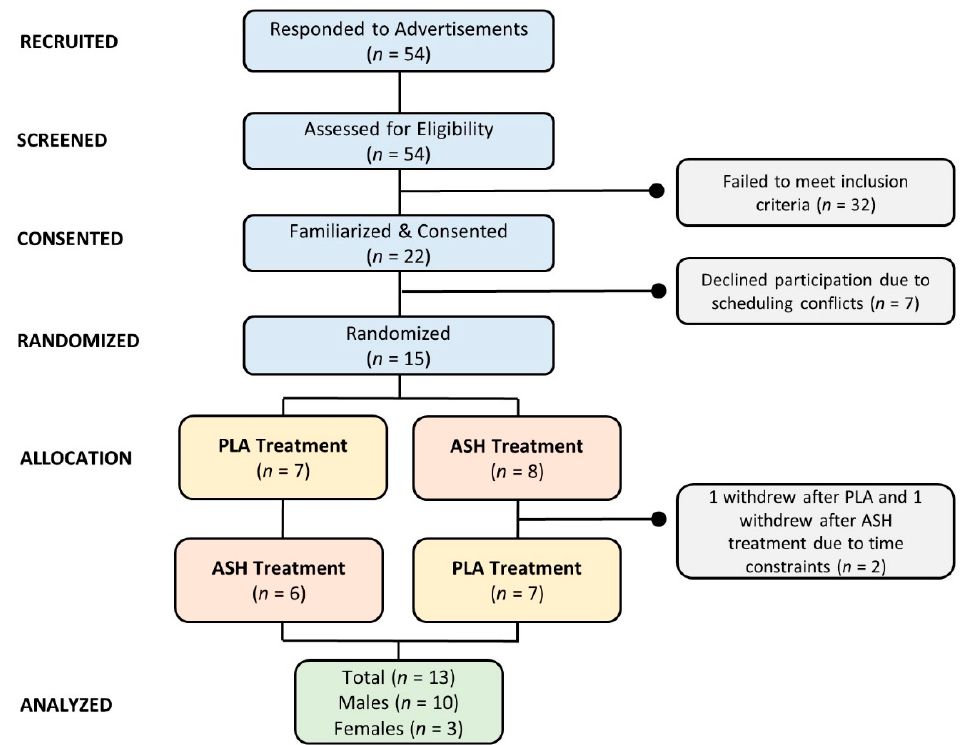
Figure 1. Consolidated Standards of Reporting Trials (CONSORT) diagram. PLA represents placebo, and ASH represents ashwagandha treatments.